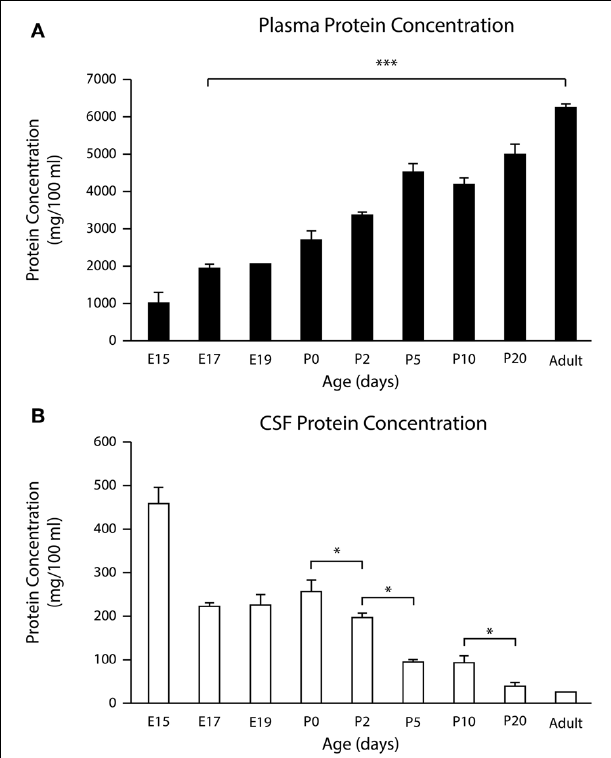
FIGURE 5 | Total protein concentration in (A) and in CSF (B) during development in the mouse. Mean ± SEM ( n = 3–4). ∗ p < 0 . 05 compared with previous age group. E15 data from Liddelow et al. (2014). In CSF, maximum concentration was in the youngest embryos examined (E15). The lowest concentration was in adults. In plasma the lowest protein concentration was at E15 with a progressive increase to adulthood. ∗∗∗ p < 0 . 001. E, embryonic day; P, postnatal day.